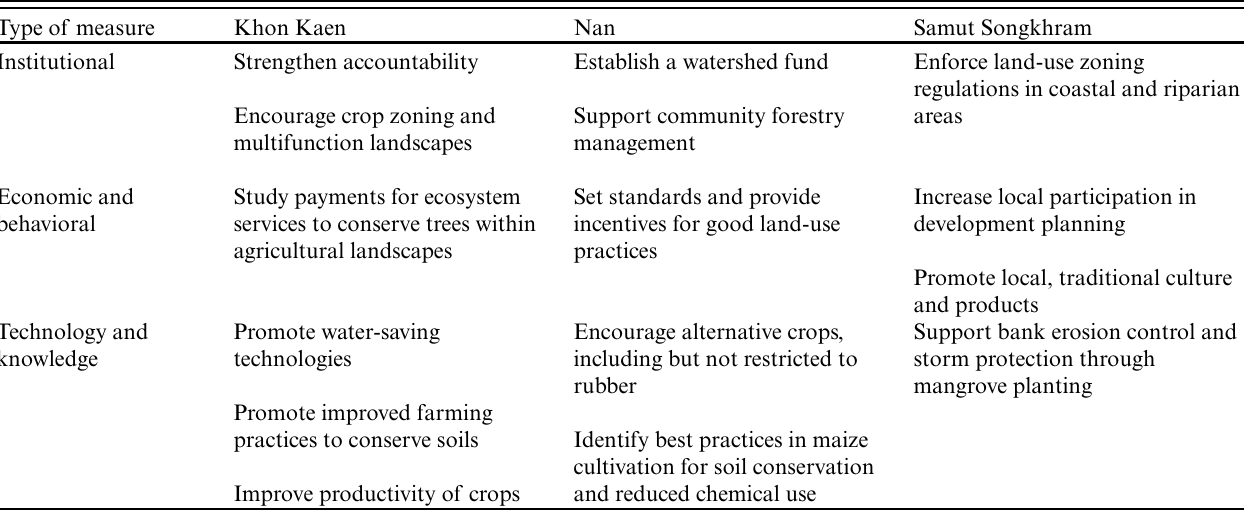
Table 2 . Examples of suggested response measures in the three